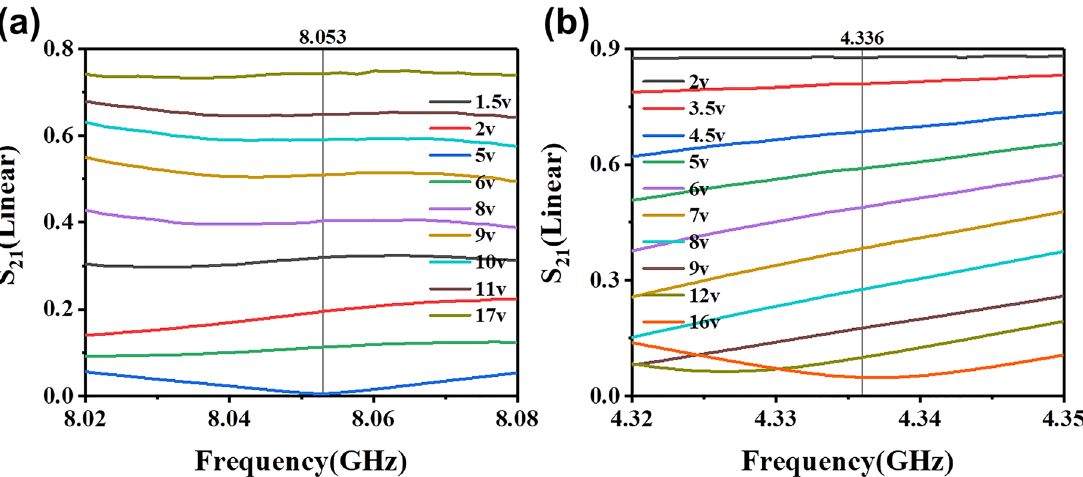
Figure 7: The S 21 curves at (a) 8.05 GHz and (b) 4.34 GHz of the new SSPP-based MZI structure with h = 4 mm and h 2 = 3.5 mm at different applied